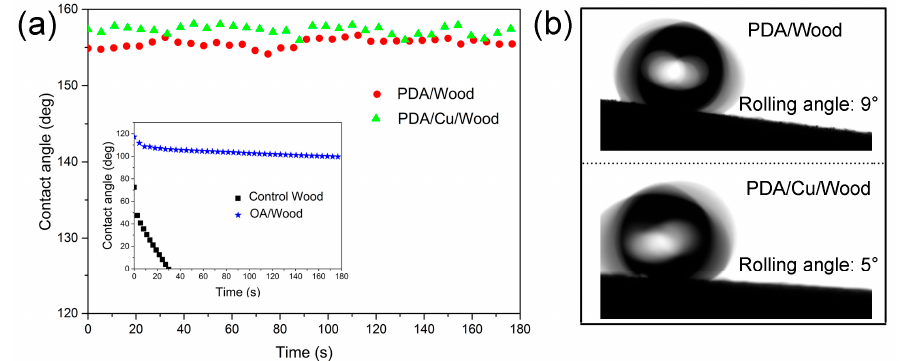
Figure 3. Superhydrophobic performance characterization, ( a ) contact angles as a function of time for control wood and OA/Wood (inset), PDA/Wood, and PDA/Cu/Wood; ( b ) the profile of water droplets rolled down on the inclined surface of the PDA/Wood and PDA/Cu/Wood samples.